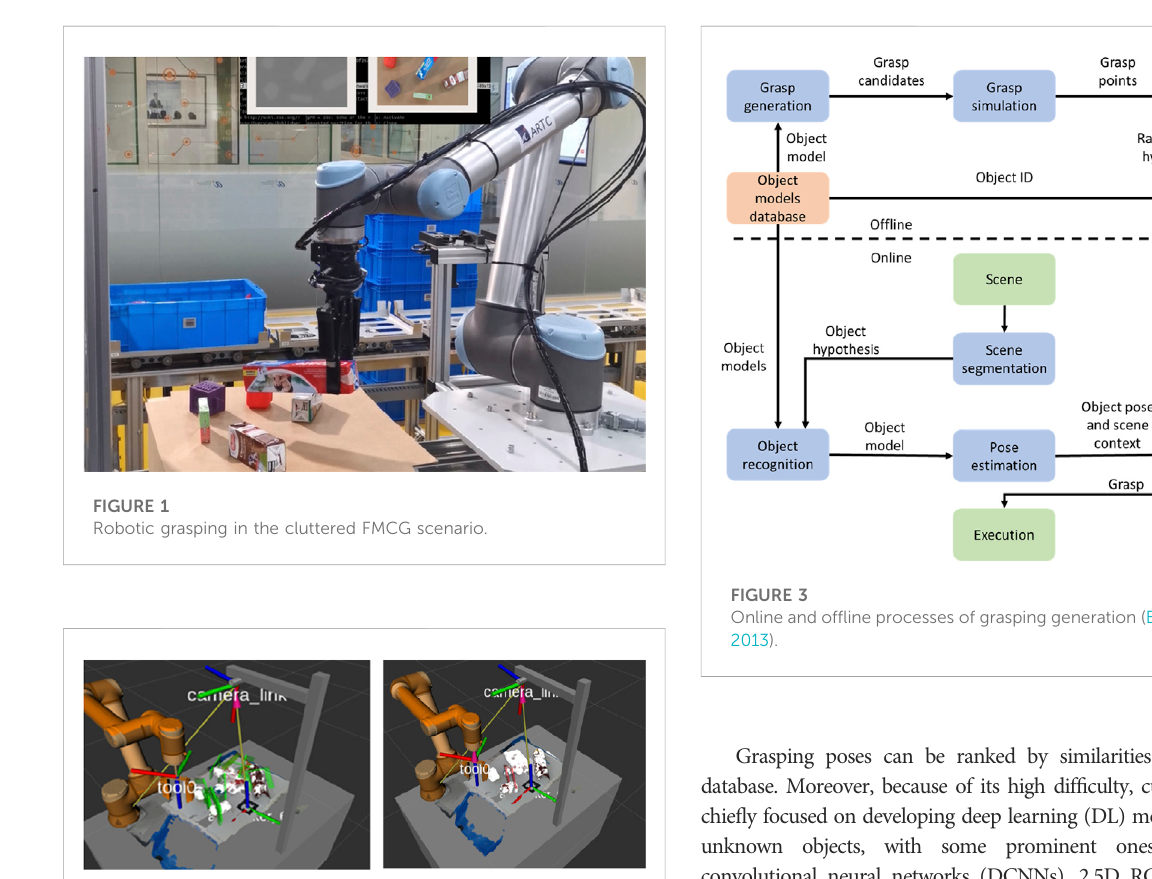
Figure 1. These high-mixed SKUs include various types of products, for example, heavy, light, fl at, large, small, rigid, soft, fragile, deformable, and translucent.